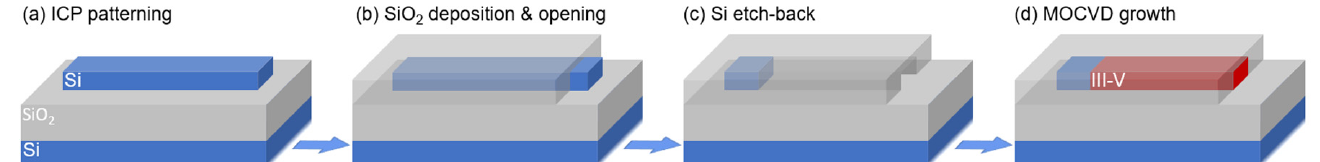
Figure 1. Schematic comparison for several integration methods for III ‐ Vs (red) on Si (blue) and SiO 2 (grey). Color shading symbolizes the growth direction and thereby natural orientation of heterostructures or doping profiles.